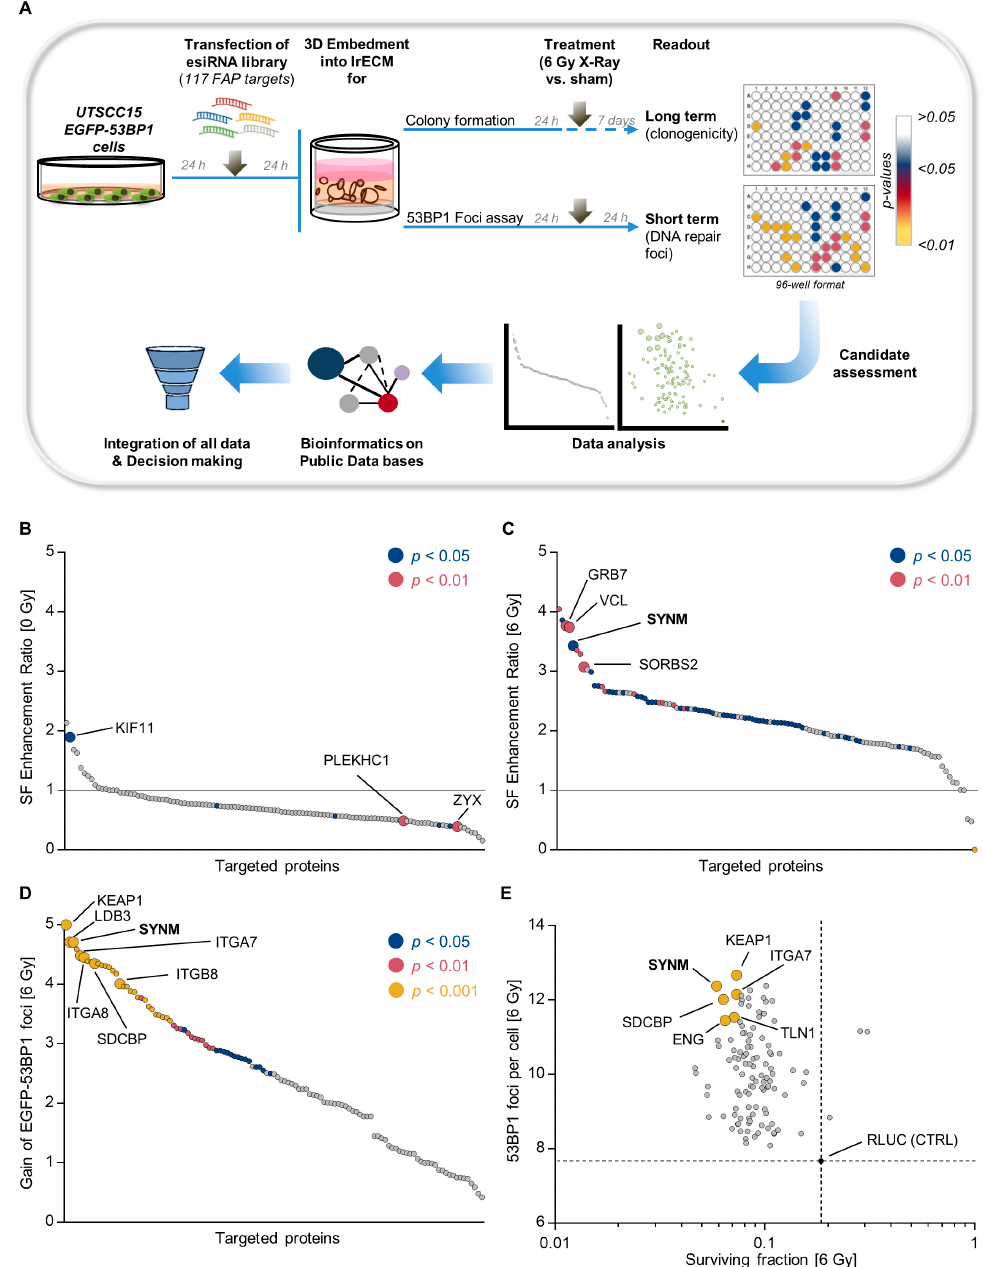
Figure 1. Identification of focal adhesion proteins affecting cell survival, radiosensitivity and DNA repair. ( A ) Workflow of 3D high-throughput RNAi screening (3D HTP-RNAi-S); ( B ) Surviving fraction-related enhancement ratios of EGFP-53BP1-expressing UTSCC15 cell cultures in response to focal adhesion protein (FAP) knockdowns ( n = 4), the data and p -values for which are provided in Table S2; ( C ) Surviving fraction-related enhancement ratios of FAP knockdown cell cultures exposed to 6-Gy X-rays ( n = 4), the data and p -values for which are provided in Table S3; ( D ) Gain of residual 53BP1 foci number per cell (24 h after irradiation) in FAP knockdown cell cultures irradiated with 6-Gy X-rays (53BP1 foci in controls were subtracted from the total number of foci) ( n = 4); ( E ) Scatter plot displaying the relation between 53BP1 residual foci / cell and surviving fraction upon FAP knockdown and 6-Gy irradiation. Main selected candidates with high foci / cell and low cell survival are indicated. SF, surviving fraction; CTRL,